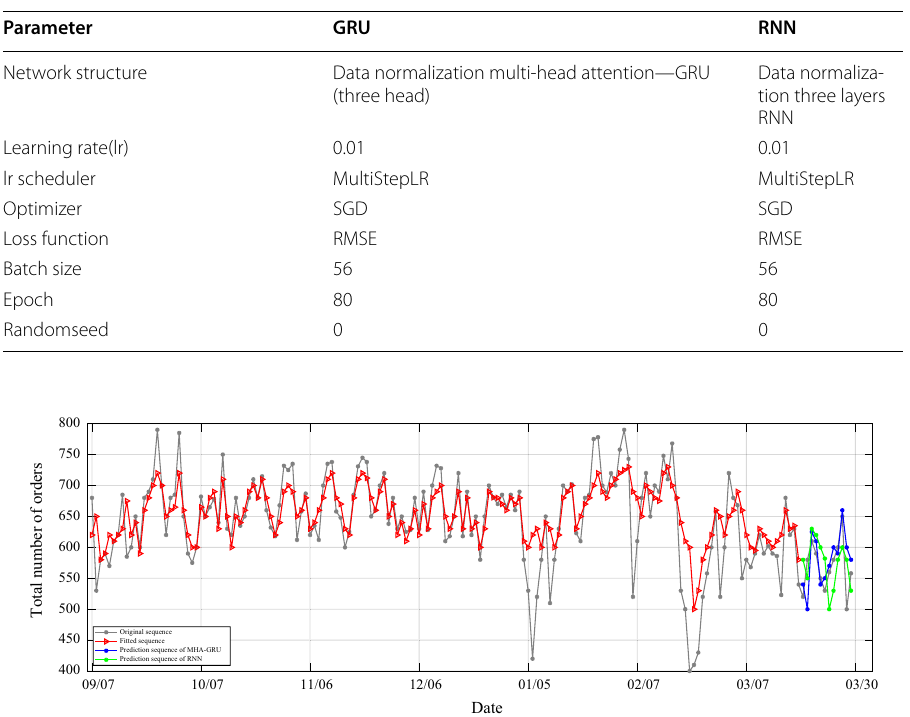
Fig. 9 RNN versus MHA-GRU: prediction results of